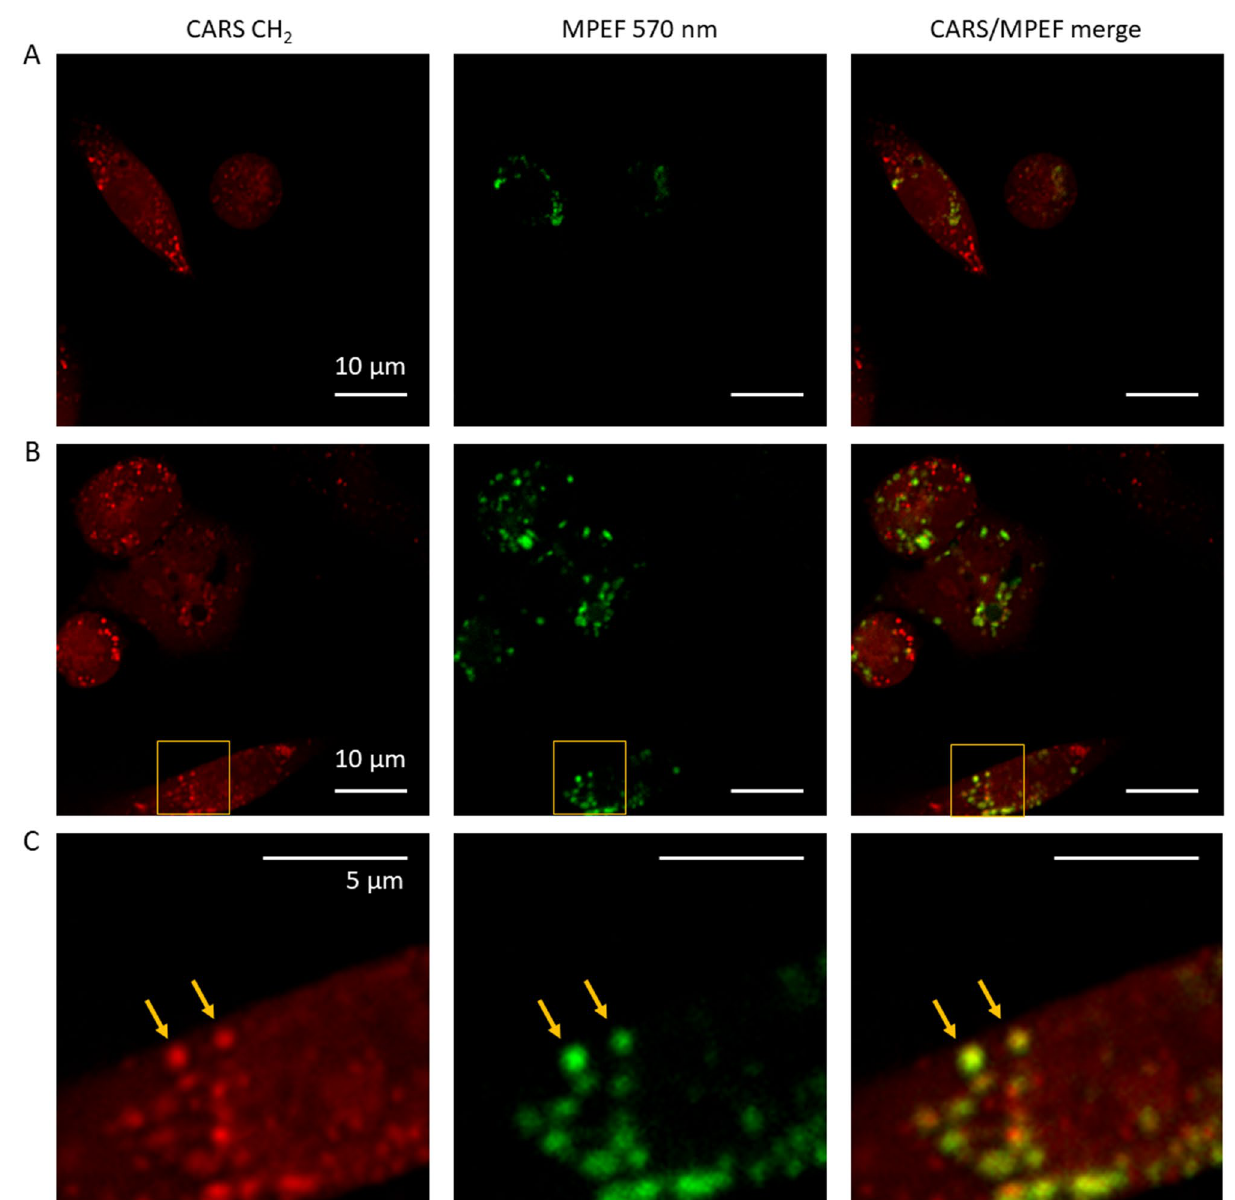
Figure 5. CARS and MPEF images of CYTO-ID Green labeled MIAPaCa-2 cells. ( A ) CARS (left), MPEF (middle), and CARS/MPEF (right) images of MIAPaCa-2 cells acquired at 37 °C. ( B ) CARS and MPEF images of MIAPaCa-2 cells collected at 24 °C after hypothermia exposure. ( C ) Magnified selected areas in panel ( B ). Arrows indicate molecular targets with both strong signals in CARS and